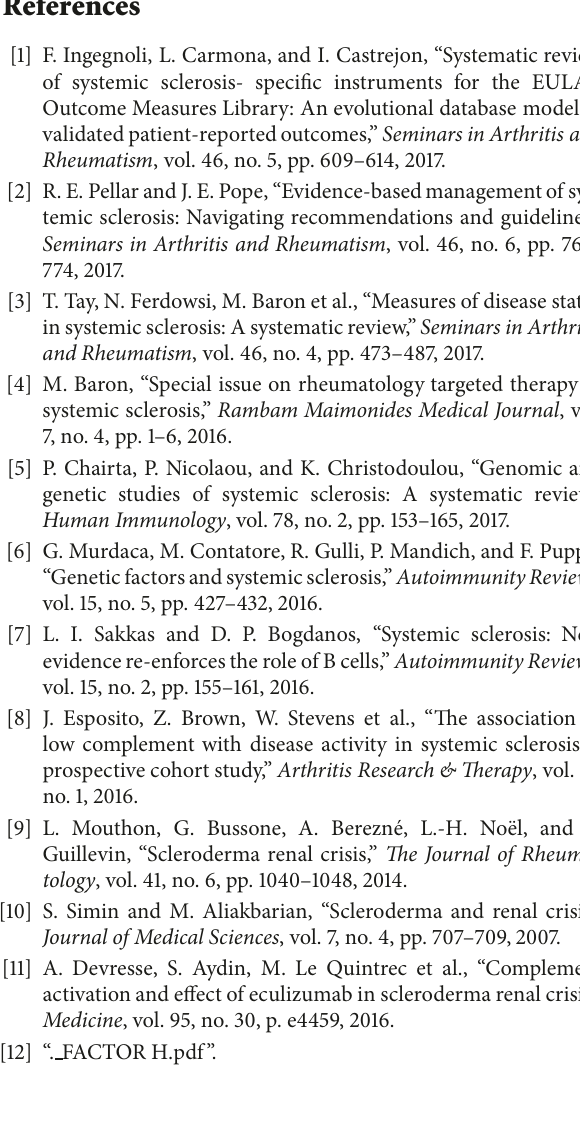
system through the classical pathway may be are